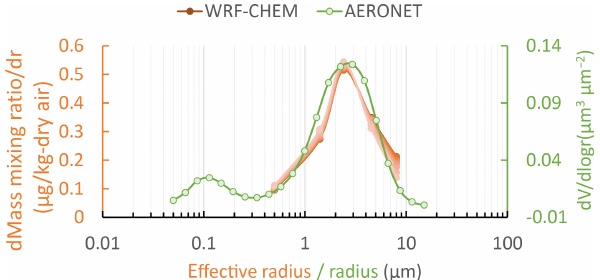
Figure 10. Comparison between the volume size distribution of AERONET data (2016 average) at Kuwait University site and the mass distribution of dust-laden columns in